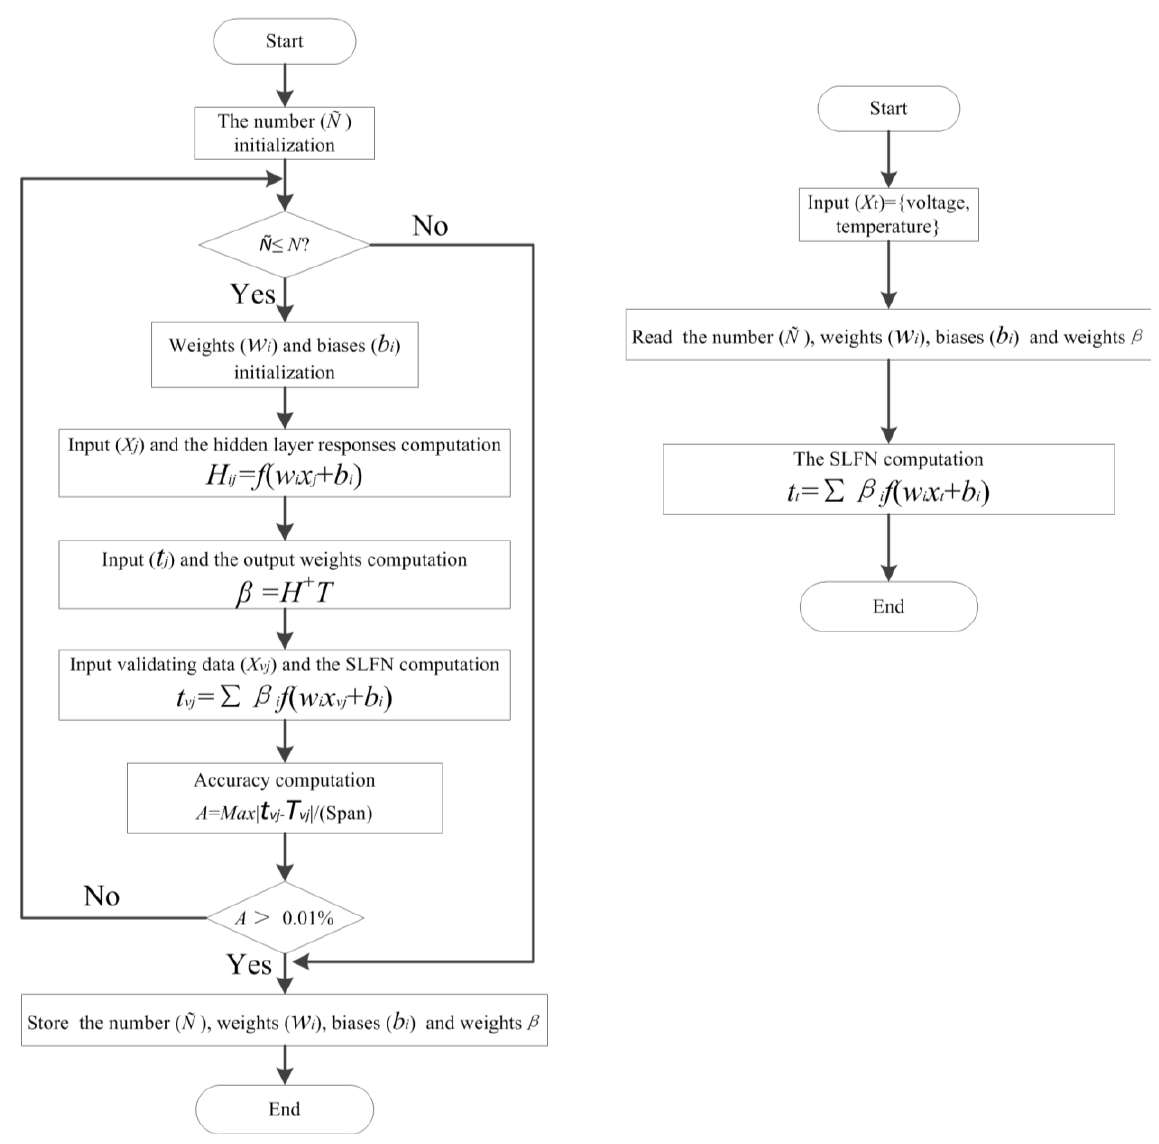
Figure 3. The temperature compensation flowchart of ELM. ( a ) Temperature calibration flowchart using SLFN trained by ELM; ( b ) Temperature compensation flowchart using the trained